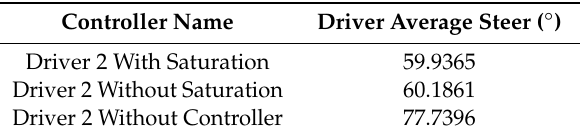
Table 2. Driver average